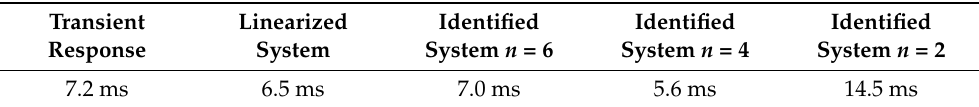
Figure 3. System order influence on observer dynamics identification for observer gains ensuring damped transient response: ( a ) impulse response of the system, ( b ) poles of the linearized system, ( c ) poles of an identified 6th order system, ( d ) poles of an identified 4th order system, ( e ) poles of an identified 2nd order system. Table 1. Comparison of settling times for observer gains ensuring damped transient response read from the output signal and placement of the